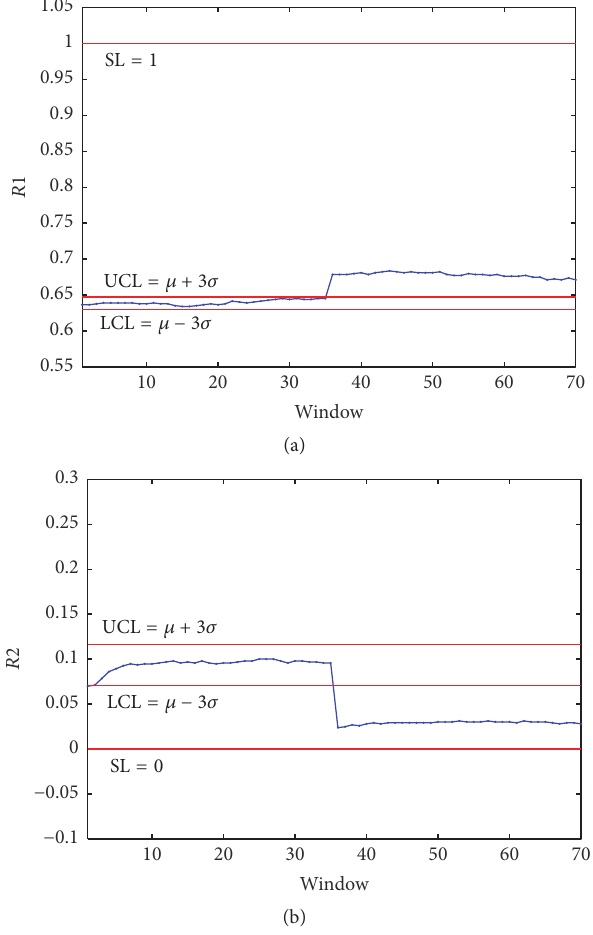
Figure 6: Stability monitoring with a process change 𝐺 𝑝 = (0.6 − = (0.45 − 0.3𝑧 −1 )/(1 − 0.7𝑧 −1 ) 0.3𝑧 −1 )/(1 − 0.7𝑧 −1 ) → 𝐺 𝑝